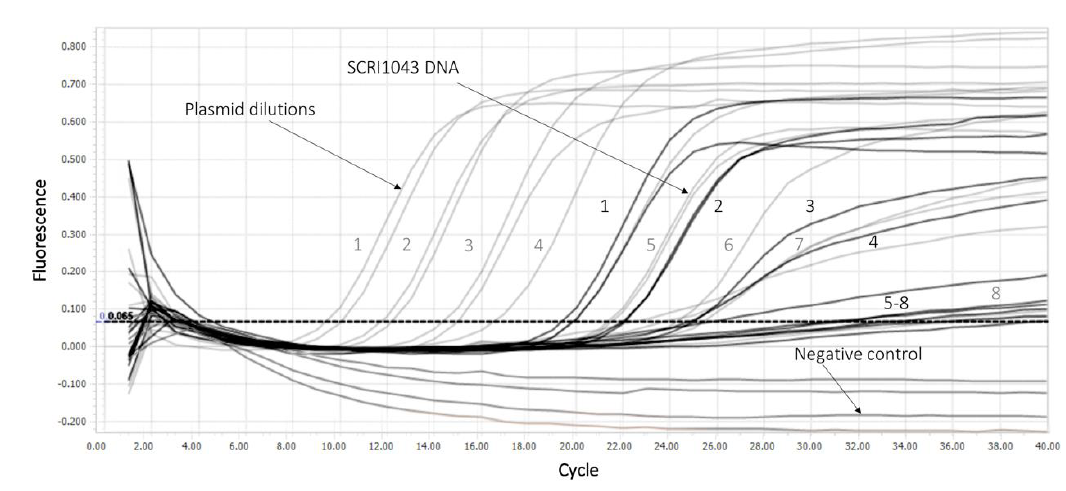
Figure 5. Sensitivity of P. atrosepticum detection using the PCR assay. Plasmid dilutions are marked in grey, genomic DNA dilutions are marked in black, the negative control is marked. The numbers represent the corresponding dilutions shown in Table 2.